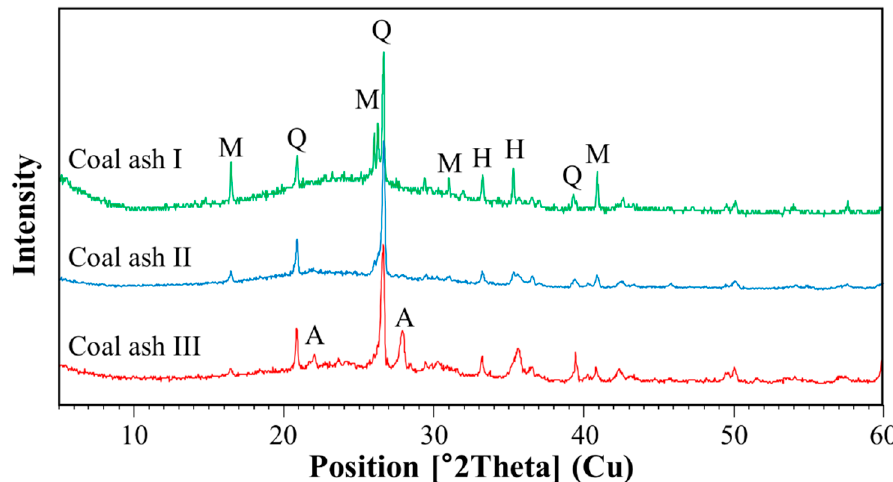
Figure 5. X-ray diffraction patterns for fillers: ( a ) CA I, ( b ) CA II and ( c ) CA III (M: mullite, Q: quartz, H: hematite, A: anorthite).